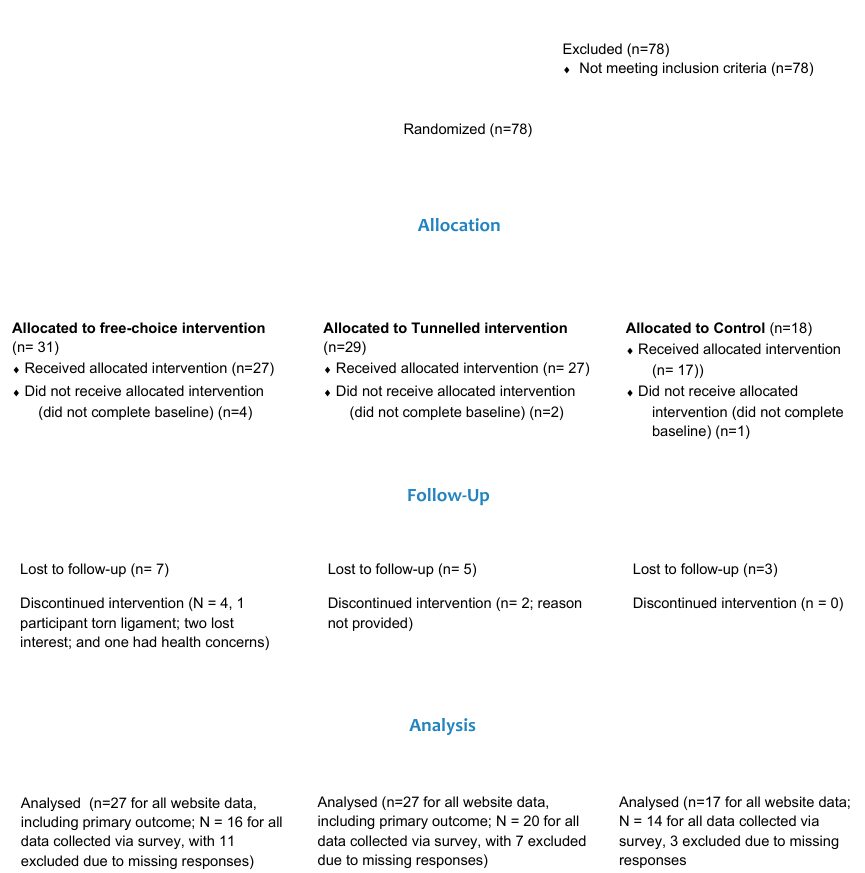
Figure 4. Consort flow diagram illustrating participant flow through the trial.